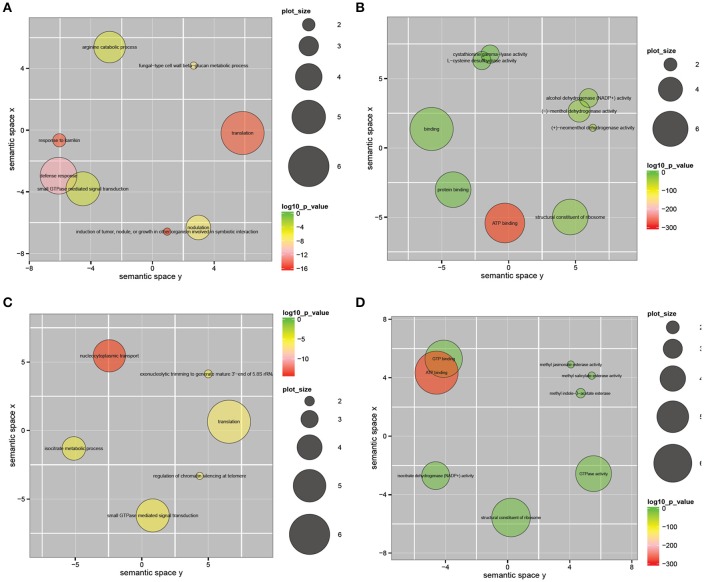
Gene ontology enrichment analysis of 450 pairs of unigenes that showed significant positive or negative correlation (correlation coefficients r > 0.65 or r < −0.65, p < 0.05) between the gene expression modes in V. fordii and V. montana. (A) Significantly positively correlated GO term in biological process; (B) significantly positively correlated GO term in molecular function; (C) significantly negatively correlated GO term in biological process; (D) significantly negatively correlated GO term in molecular function. The scatterplot shows the cluster representatives in a two dimensional space derived by applying multidimensional scaling to a matrix of the GO terms' semantic similarities. Bubble color indicates the log 10 p-value (legend in upper right-hand corner); plot size indicates the frequency of the GO term in the underlying GOA database (bubbles of more general terms are larger).